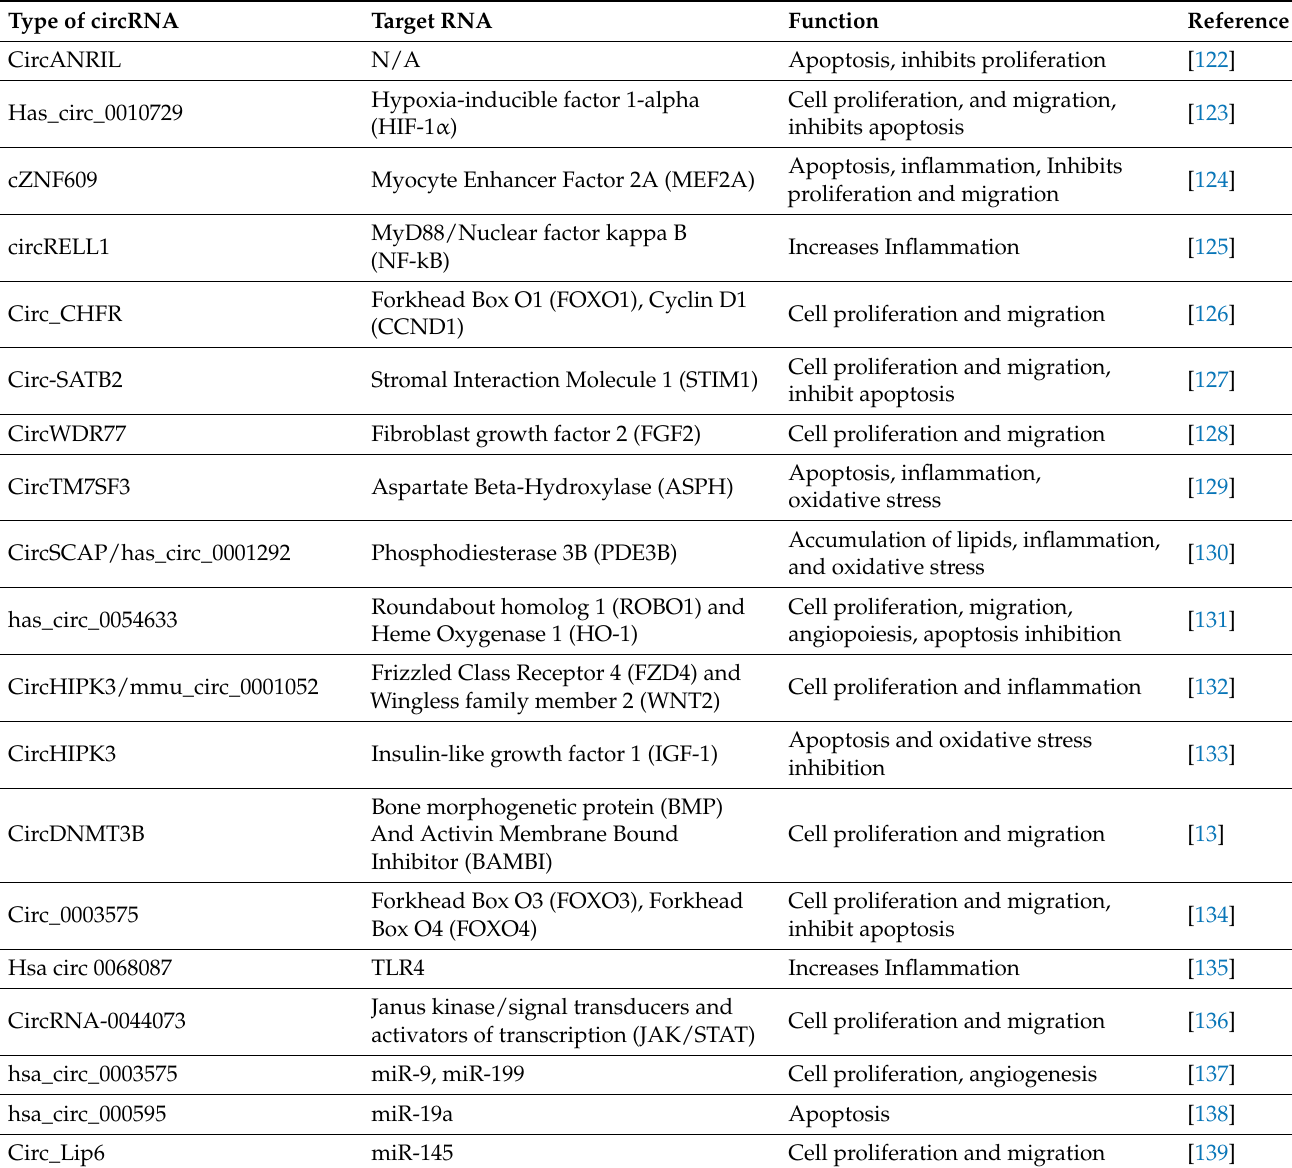
Table 2. Circular RNAs, their targets, and